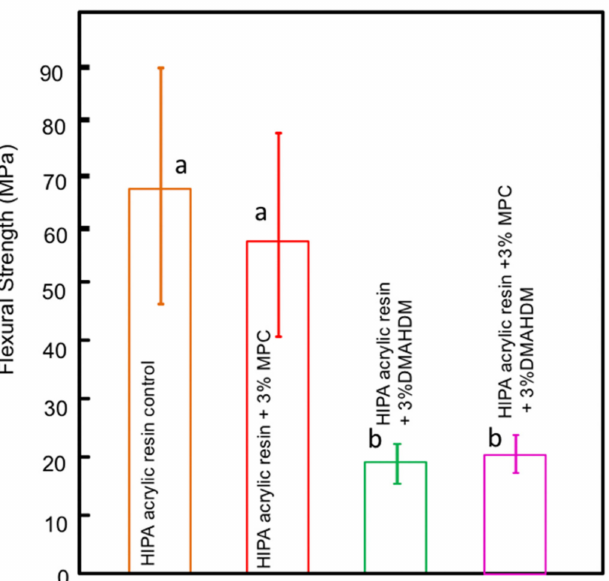
Figure 2. Flexural strength of the acrylic resin; similar letters indicate statistical similarity (Tukey’s test, p < 0.05).